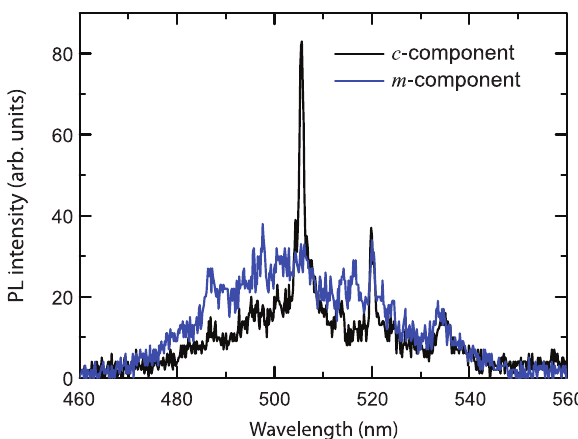
Figure 5: The μ -PL of a QD ( ~ 505 nm) and its underlying fQW. The QD is polarized along the c -direction, while the fQW is polarized along the m -direction, corresponding to one of the 9% special cases in which a -plane QDs are polarized parallel to the crystal c